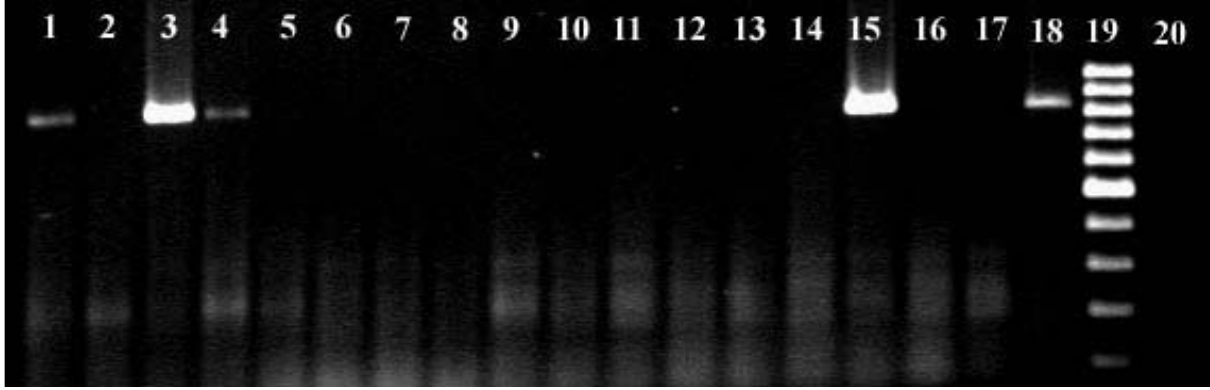
Fig. 3. Agarose gel electrophoretic analysis of the RT-PCR products (730 bp) of caper regenerated plantlets after thermothe- rapy and tip culture. Lane 1–10, Salina genotype; lane 11–16 Pantelleria genotype; line 17, virus-free seed-borne caper (negative control); line 18, CapLV infected caper (positive control); lane 19, 100 bp DNA ladder; lane 20, water